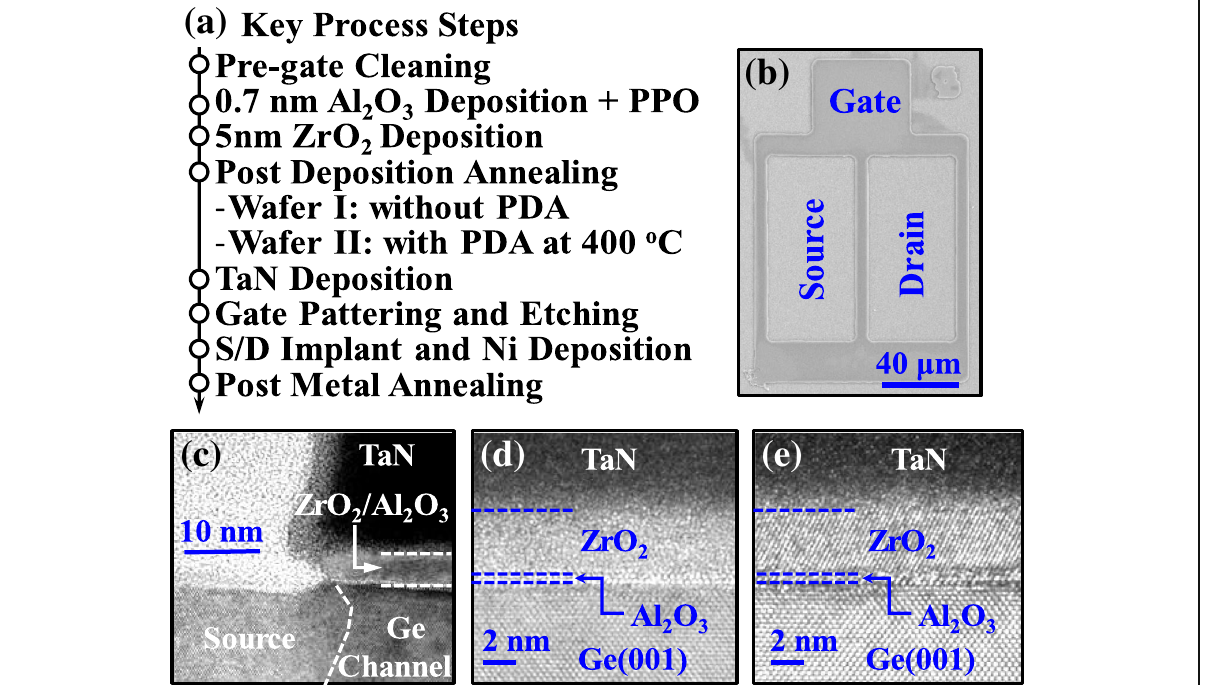
Fig. 1 a Key process steps for fabricating Ge pMOSFETs with ZrO 2 dielectric. b SEM image of the fabricated transistor. c XTEM image of Ge pMOSFET showing the gate and S/D regions. d , e HRTEM images of gate stacks of Ge pMOSFETs on wafer I annealed at 400 °C and 500 °C, respectively